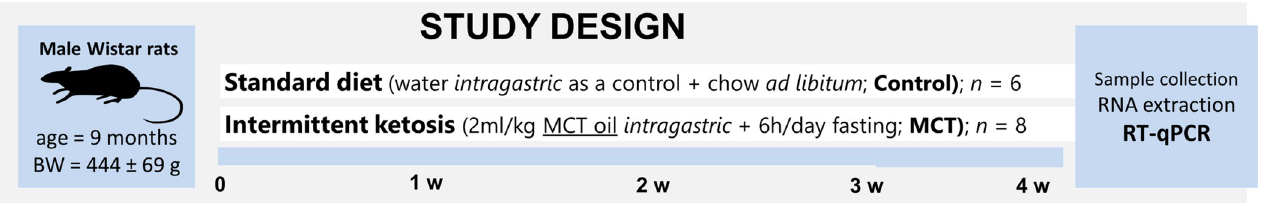
Fig 1. The design of the study aimed to assess the effect of mild ketosis on the reference gene expression stability in the rat brain. MCT (2 ml/kg body weight) were given as a supplement to standard feed to adult (9 m.o., BW = 444 ± 69 g) animals by oral gavage daily for 4 weeks, while the control rats received equivolume water. mRNA expression of nine housekeeping genes ( Actb , Gapdh , B2m , Rpl13a , Sdha , Ppia , Hprt1 , Pgk1 , Ywhaz ) in the medial prefrontal cortex, dorsal and hippocampal areas was measured by RT-qPCR.